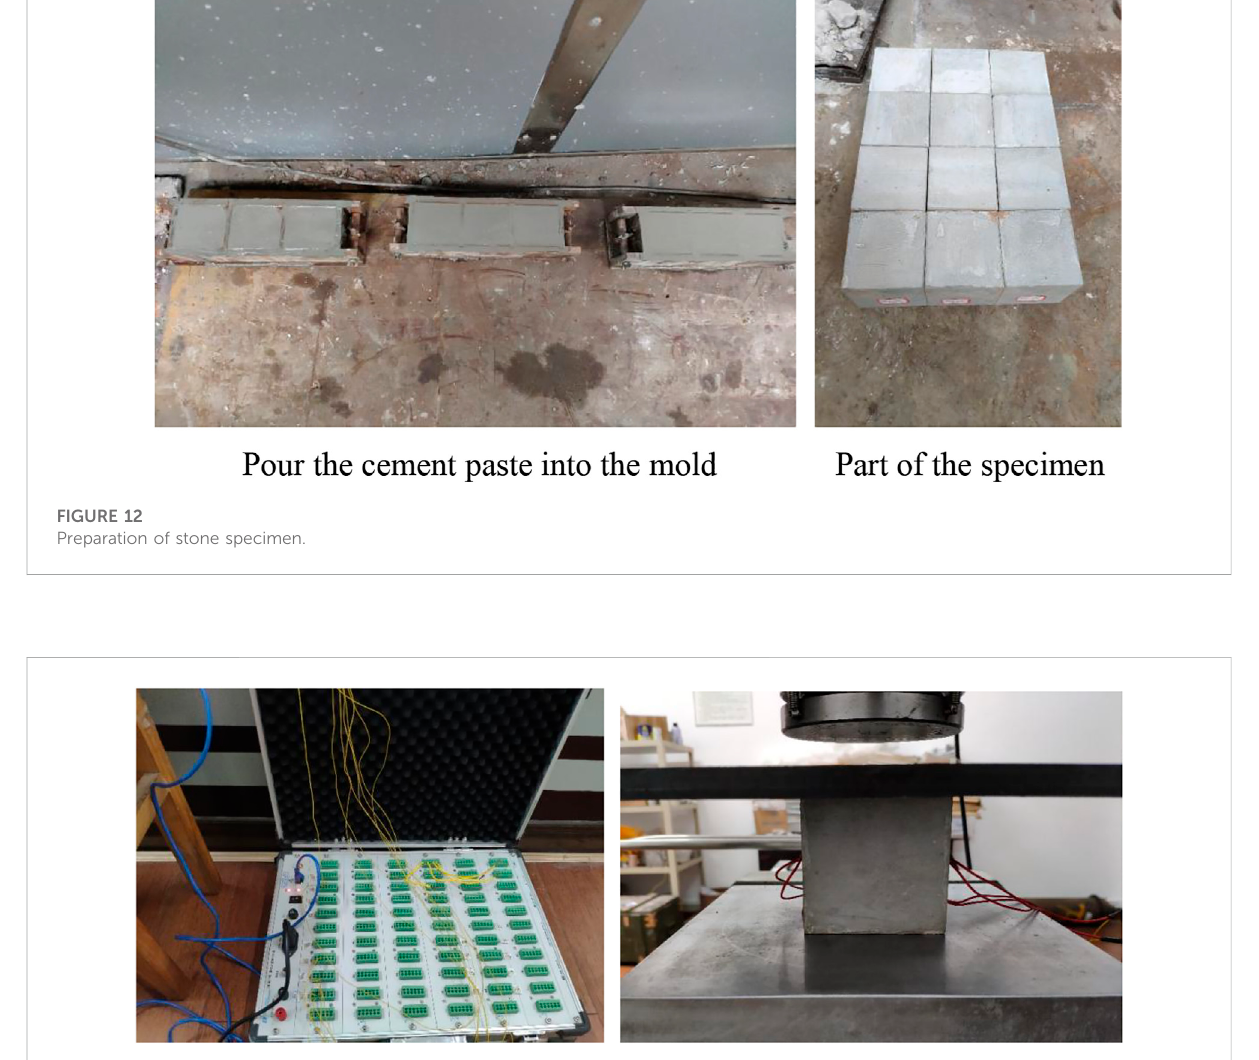
FIGURE 13 Strain acquisition system and uniaxial compression